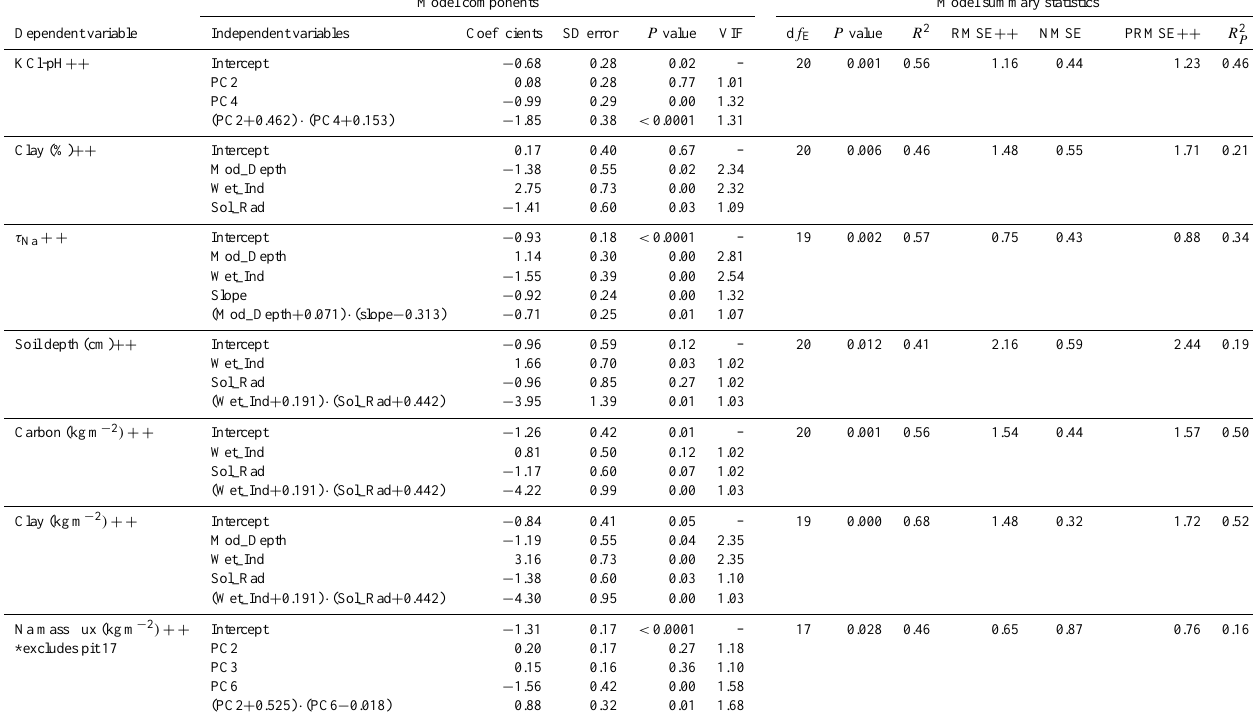
Table 6. Summary statistics of regression models for predicting logit-transformed soil physicochemical properties.